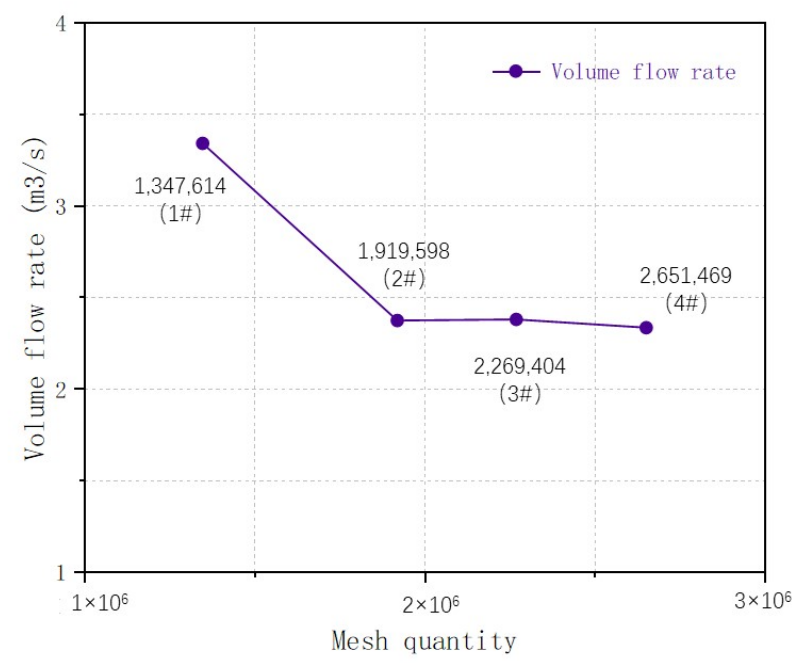
Figure 6. Volumetric flow rate under various grid sizes.